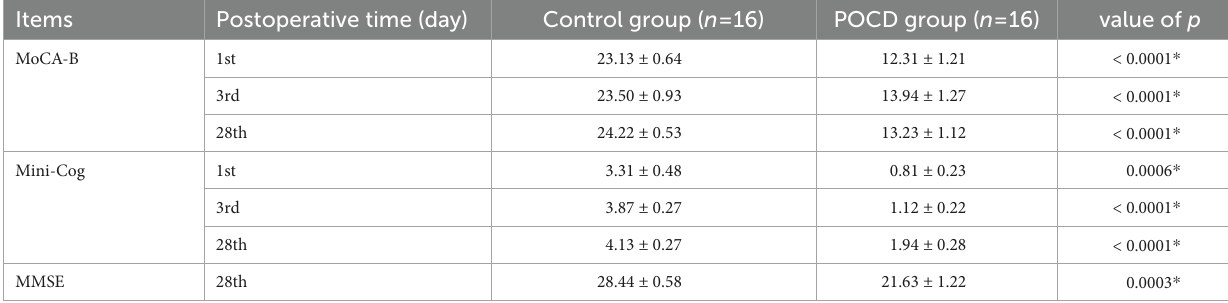
TABLE 2 Differences of neuropsychological assessment outcomes between the two groups.